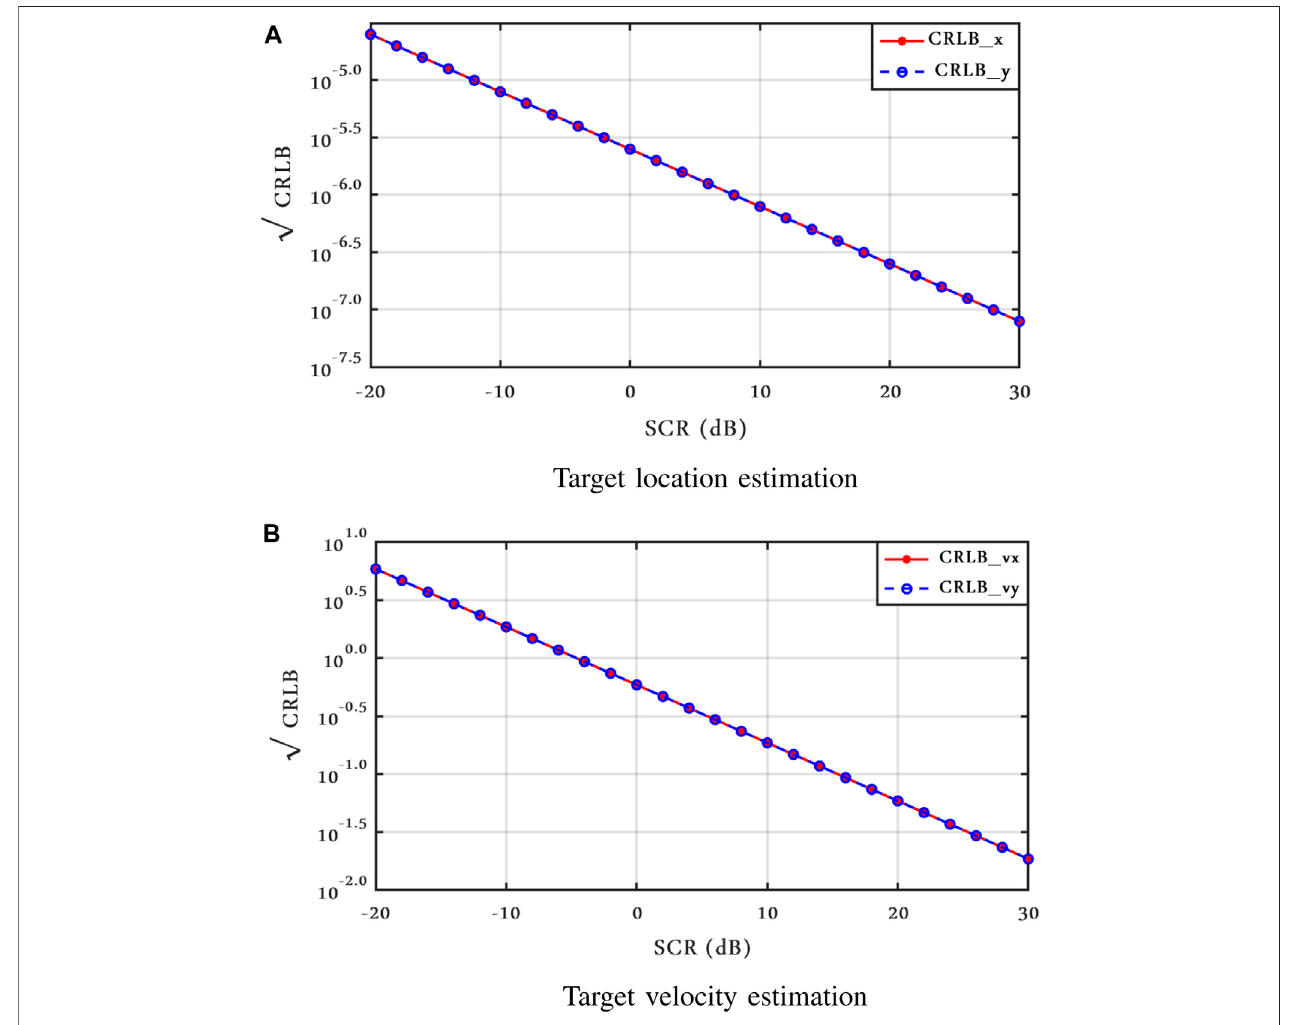
FIGURE 3 | CRLB for target location and velocity estimation in Clutter Model